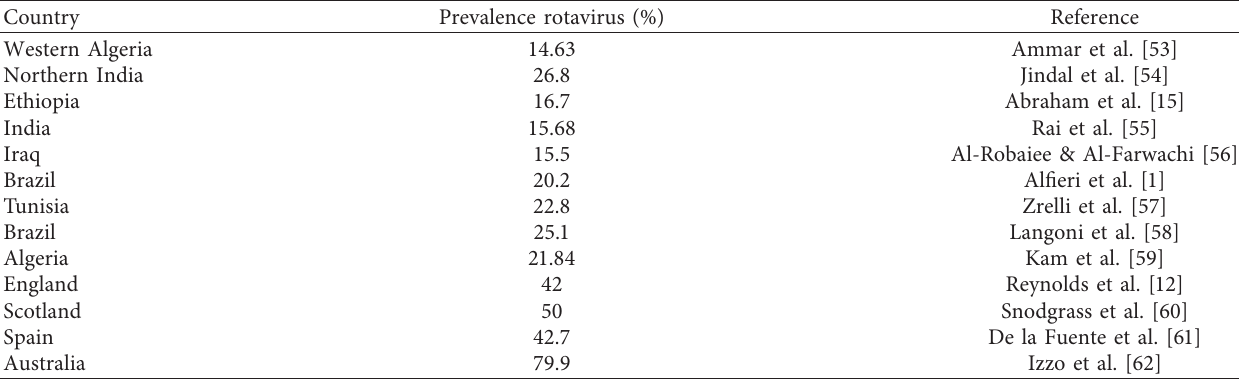
Table 5: Prevalence of rotavirus infection in